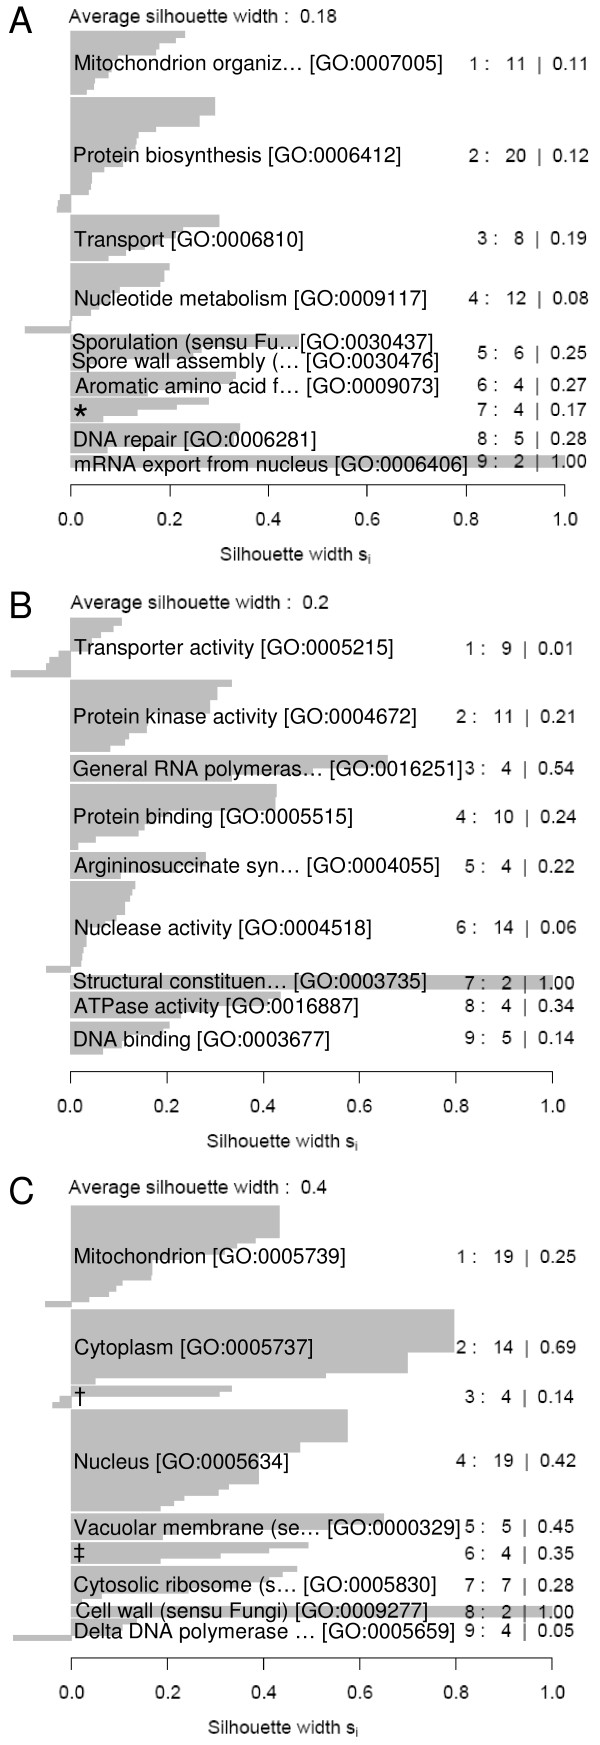
Silhouette plots of PAM clustering results for Snyder data set. Silhouette plots of PAM clustering results for 91 phospholipid binding proteins for GO (A) BP, (B) MF and (C) CC. Proteins assigned either the unknown term from each GO aspect (GO:0000004 biological process unknown, GO:0005554 molecular function unknown and GO:0008372 cellular component unknown) or using the evidence code Inferred from Electronic Annotation were not included in the clustering. Therefore 72 proteins were clustered in BP, 63 in MF and 78 in CC. The silhouette width for the entire set (average silhouette width, siD) is found at the top of each figure whereas the silhouette width for each cluster (siC) is found on the right-hand side of the figure with the cluster number (left of the colon) and number of proteins in each cluster (right of the colon). Each cluster is labelled with the GO annotation of the medoid, except BP cluster 7 and CC clusters 3 and 6 as the text did not fit on the figure. Each protein is represented by a bar and the width of the each bar represents the silhouette width for each protein (si). * GO annotation for BP cluster 7 is chromatin silencing [GO:0006342] and histone deacetylation [GO:0016575]. † GO annotation for CC cluster 3 is mitochondrial inner membrane [GO:0005743], integral to membrane [GO:0016021] and mitochondrial nucleoid [GO:0042645]. ‡ GO annotation for CC cluster 6 is plasma membrane [GO:0005886] and integral to membrane [GO:0016021].